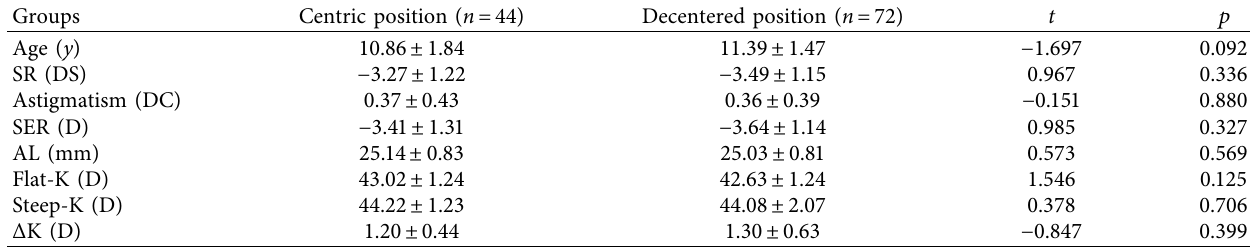
Table 1: The baseline parameters between the centric group and decentered group (mean ± SD). Groups